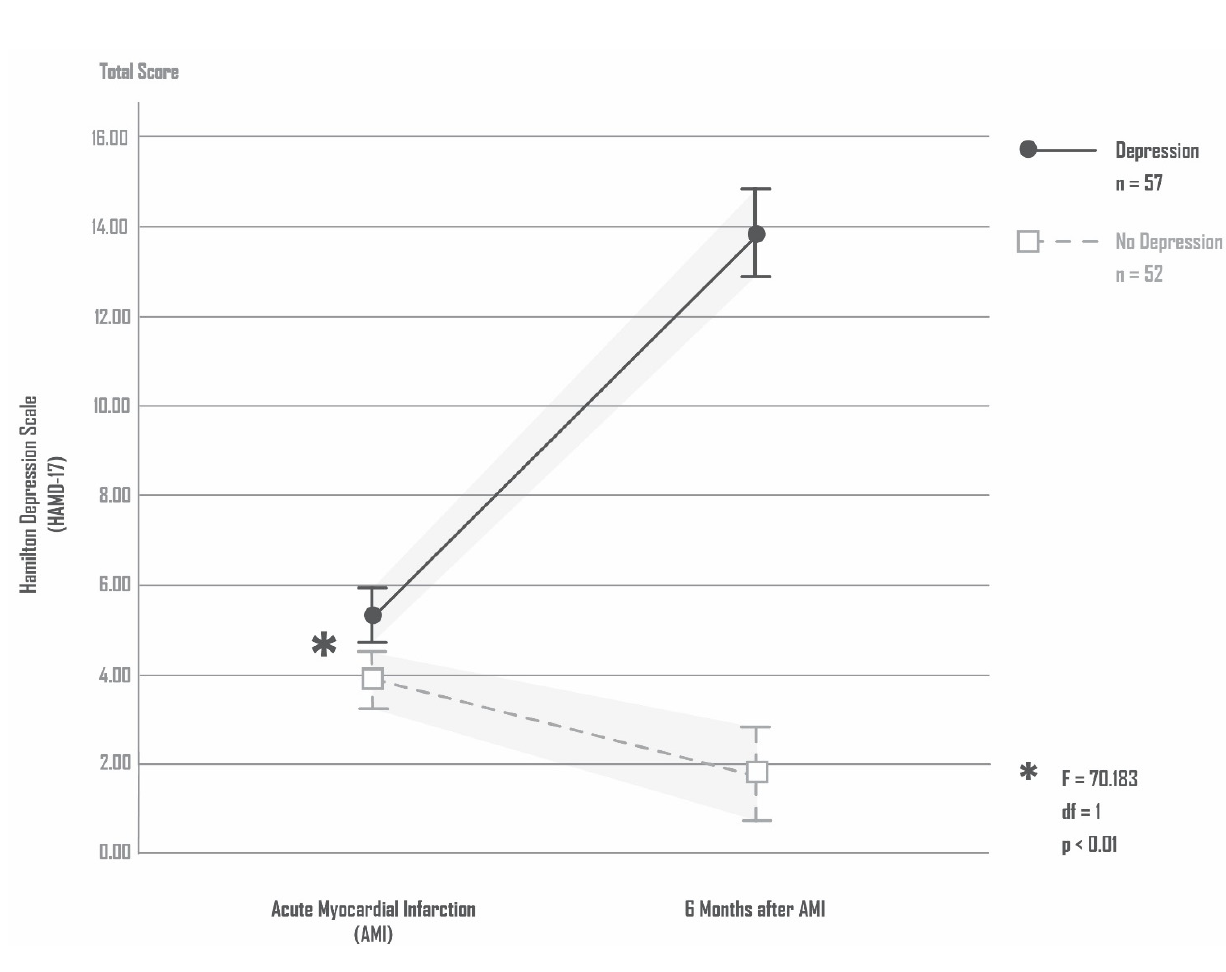
Figure 1. Total HAMD-17 scores for patients with/and without depression 6 months after AMI. Table 1. Sociodemographic and clinical characteristics of the patients with or without AMI-induced